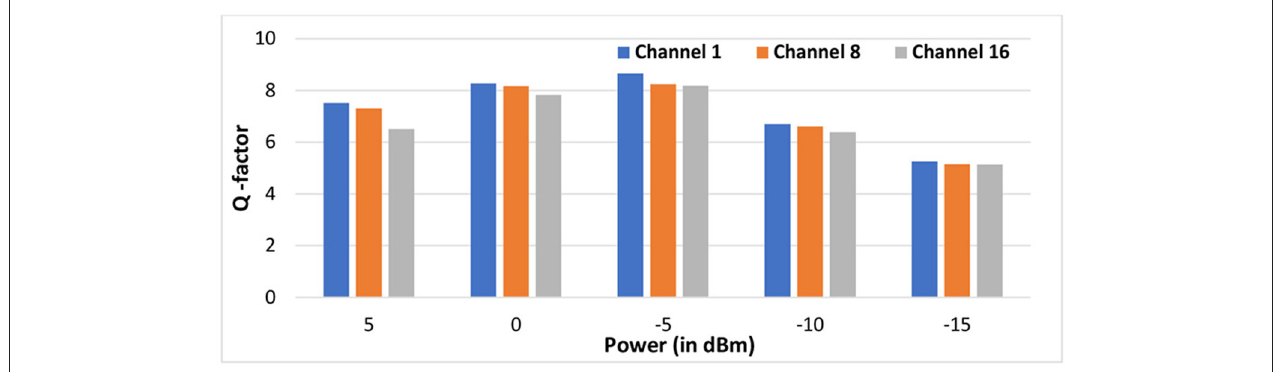
FIGURE 3 | Variation of Q factor with input power at 50 GHz channel